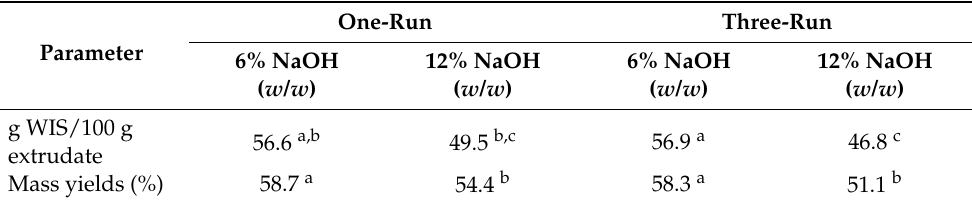
Table 2. Water insoluble content in extrudates and mass yield after extrusion pretreatment. Data expressed as percentage ( w/w ) on a DW basis. Values followed by different letter in the same row are significantly different at the 95% level.